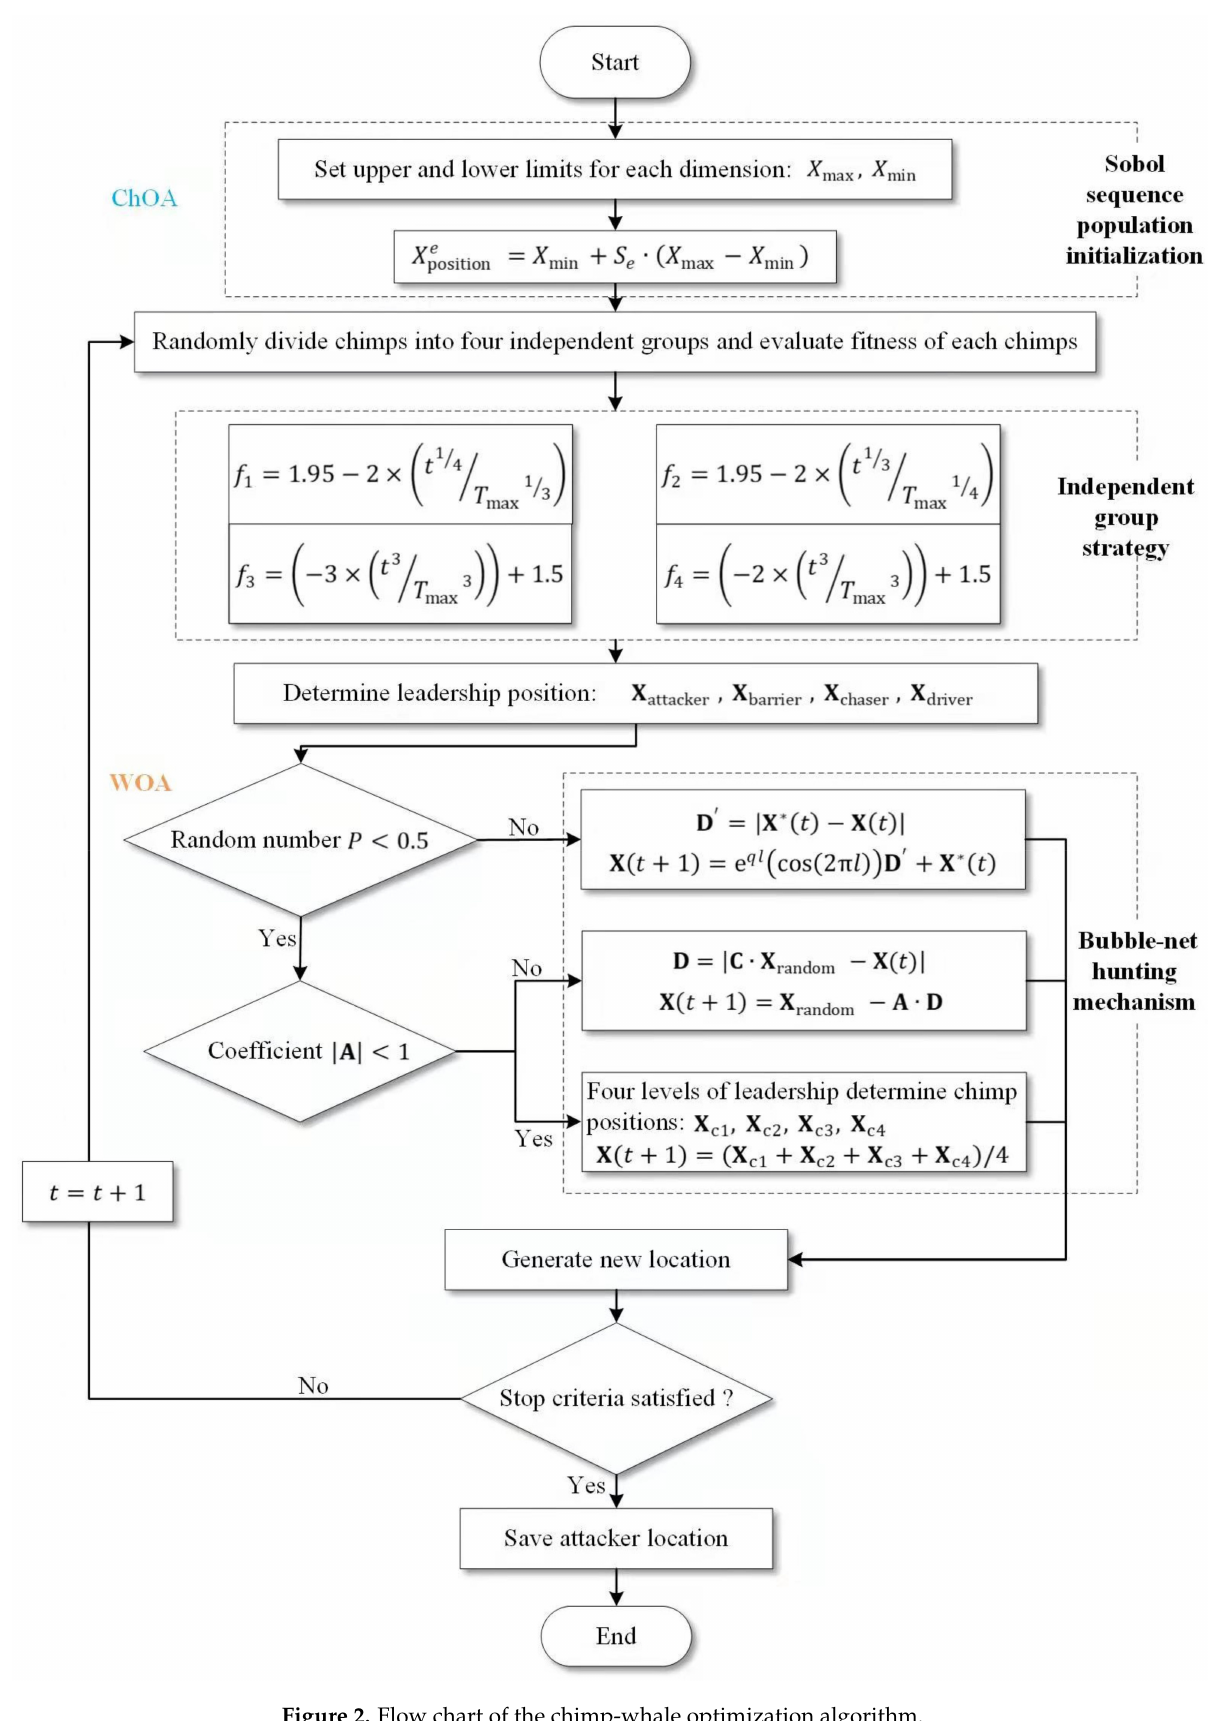
Figure 2. Flow chart of the chimp-whale optimization